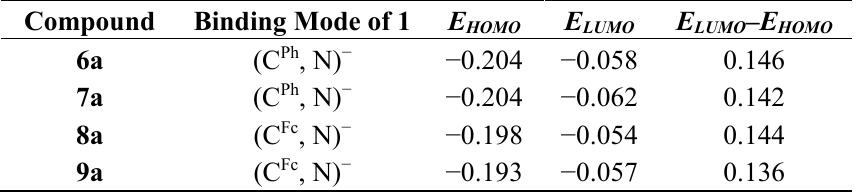
respectively) and energy gap ( E LUMO –E HOMO ) for the isomers 6a – 9a (shown in Scheme